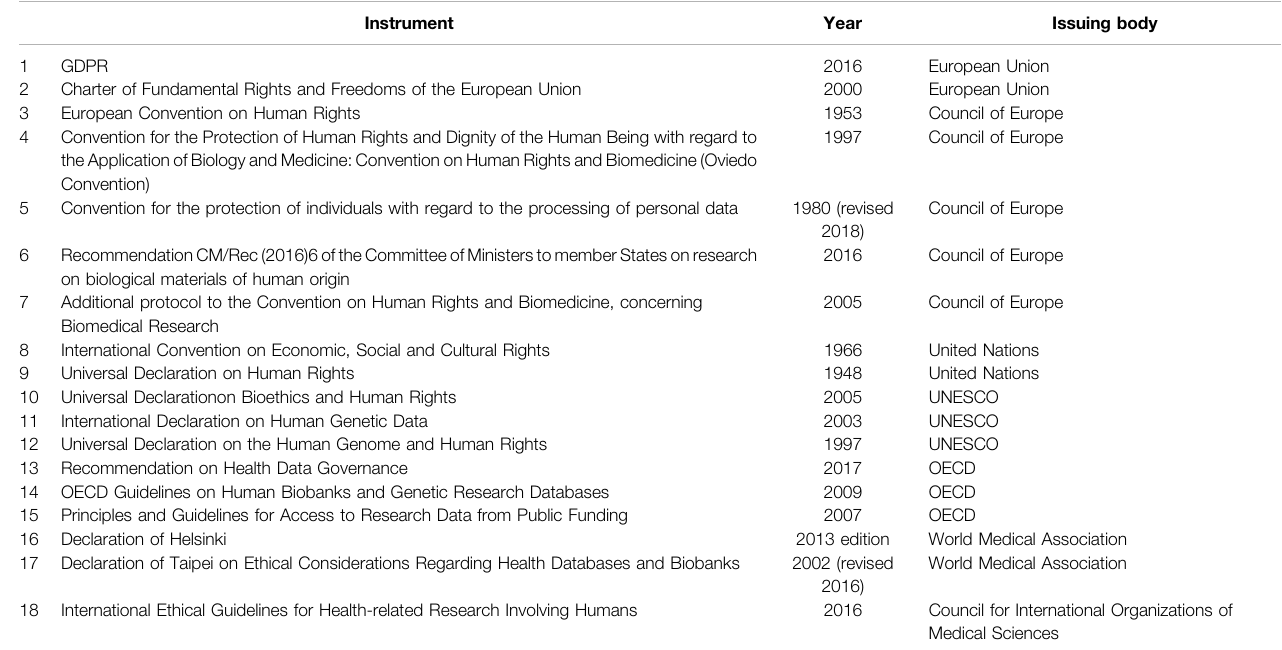
TABLE 1 | instruments from 2019